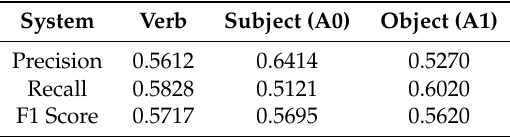
Table 11. Performance of Linguakit on Data set 1.